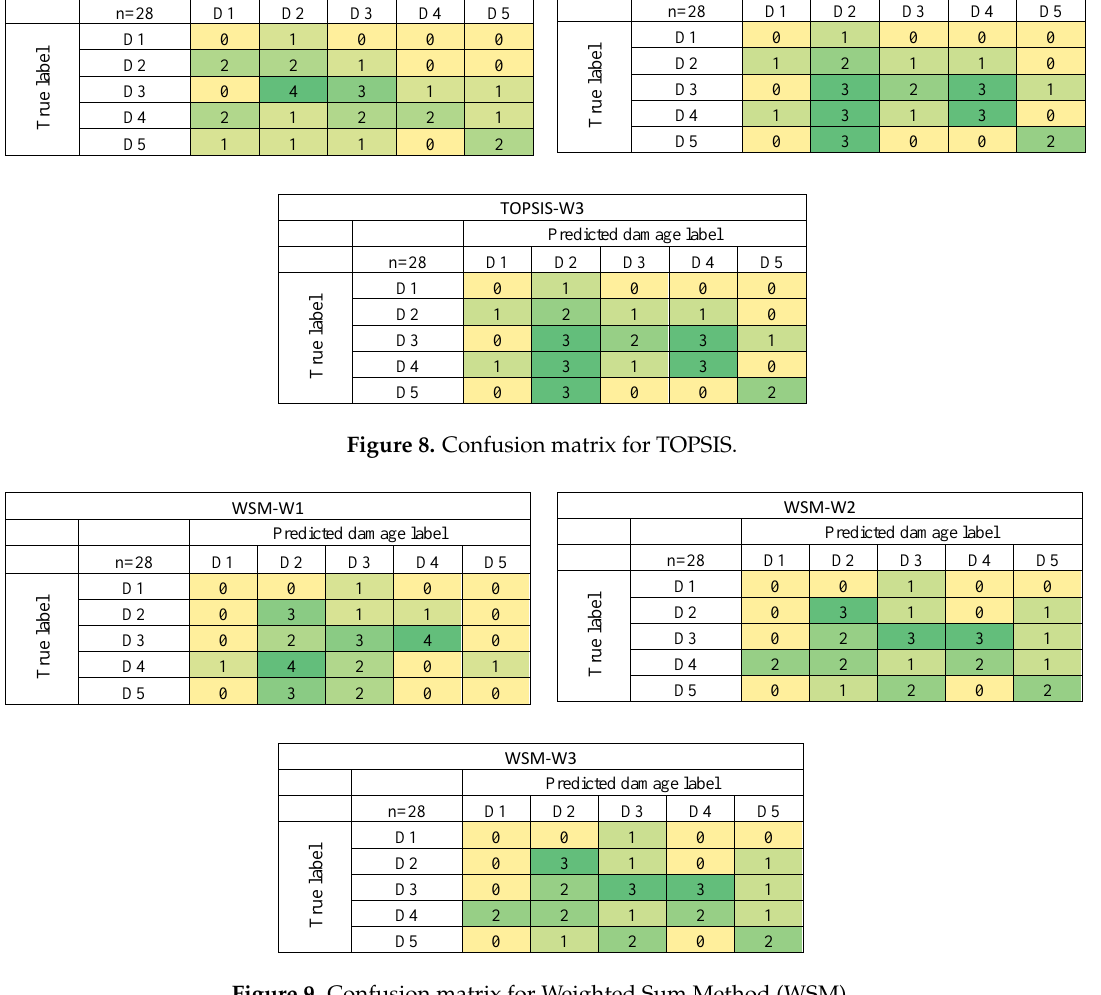
Figure 9. Confusion matrix for Weighted Sum Method (WSM).